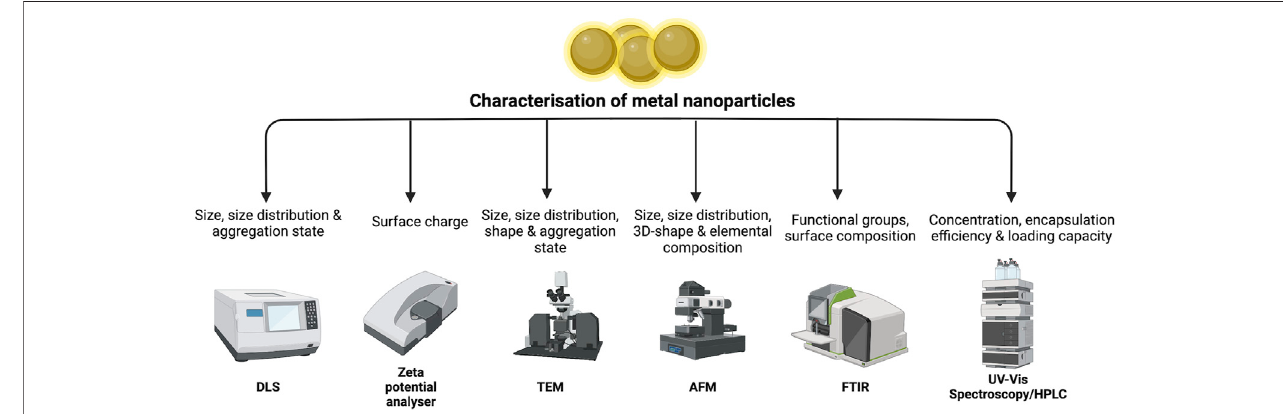
FIGURE 4 | Summary of NPs characteristics and